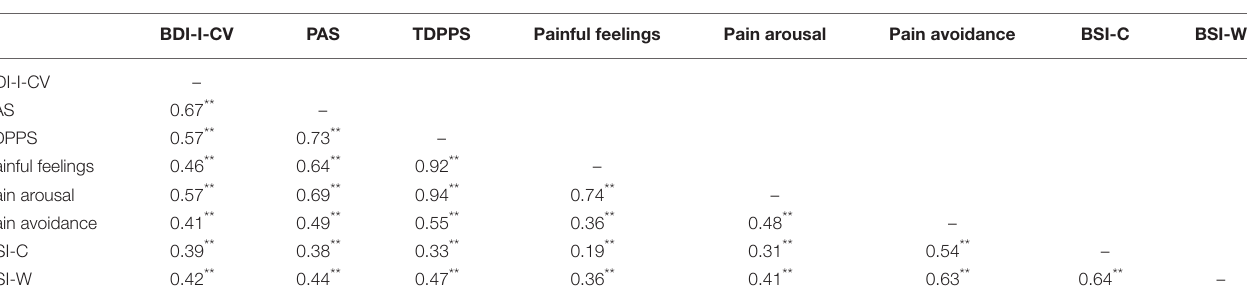
TABLE 1 | Criterion-predictor